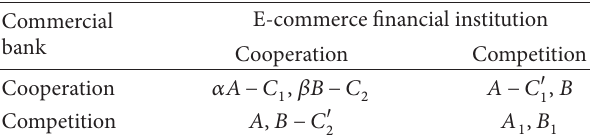
Table 2: Coopetition game payoffs